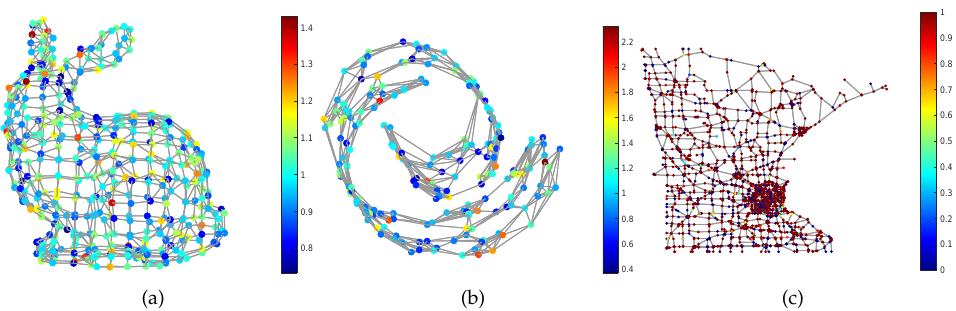
Figure 1. Illustration of smooth graph signals. The signals are supported on ( a ) The stanford bunny graph; ( b ) The swiss roll graph; ( c ) The Minnesota road